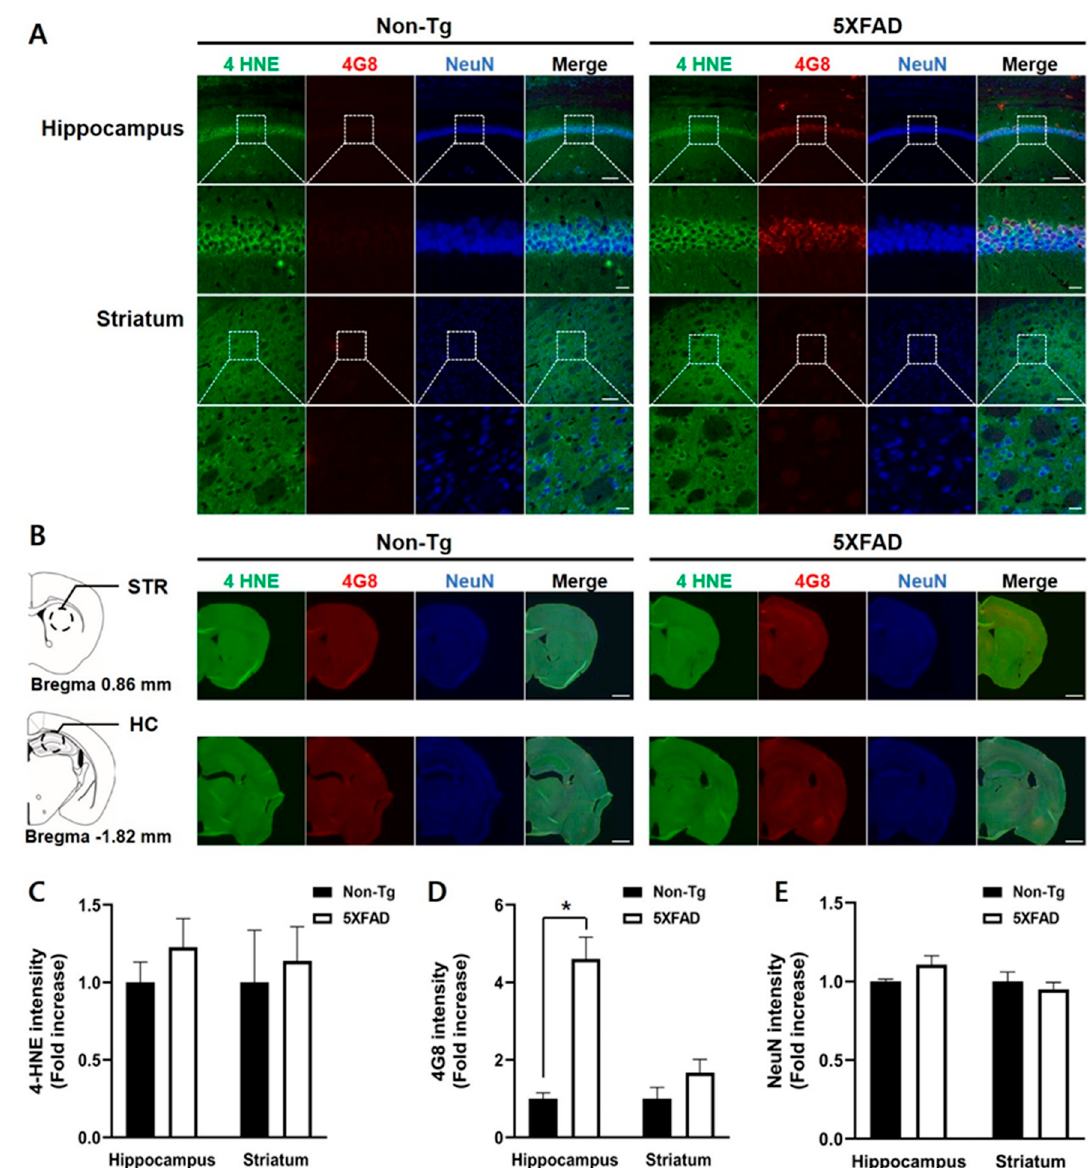
Figure 4. Triple immunofluorescence staining of the hippocampus and striatum of the 4-month-old non-Tg control and 5XFAD mice. ( A ) Confocal microscopic images of triple immunofluorescence with 4-HNE, 4G8, and NeuN antibodies in the hippocampus (HC) and striatum (STR). ( B ) Schematic diagram of the analyzed brain regions and half-brain immunofluorescence images. The dashed circle line in the diagrams indicates the region of the interest. ( C ) No differences between the two groups in the 4-HNE levels of the hippocampus and striatum were found. ( D ) Levels of 4G8-positive signals were significantly higher in the hippocampus of 5XFAD than that in control mice, but not in the striatum. ( E ) No differences in intensities of NeuN-positive signals were found between the two groups. Top row: scale bar indicates 100 μ m; bottom row: scale bar indicates 20 μ m. Non-Tg, n = 4; 5XFAD, n = 6. * p < 0.05.